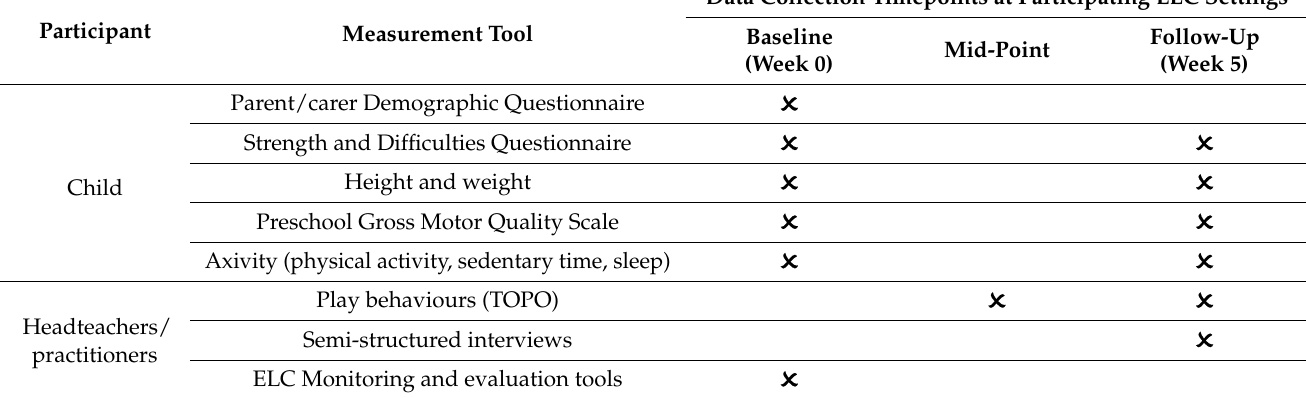
Table 4. Outcome measurement methods for the feasibility and pilot